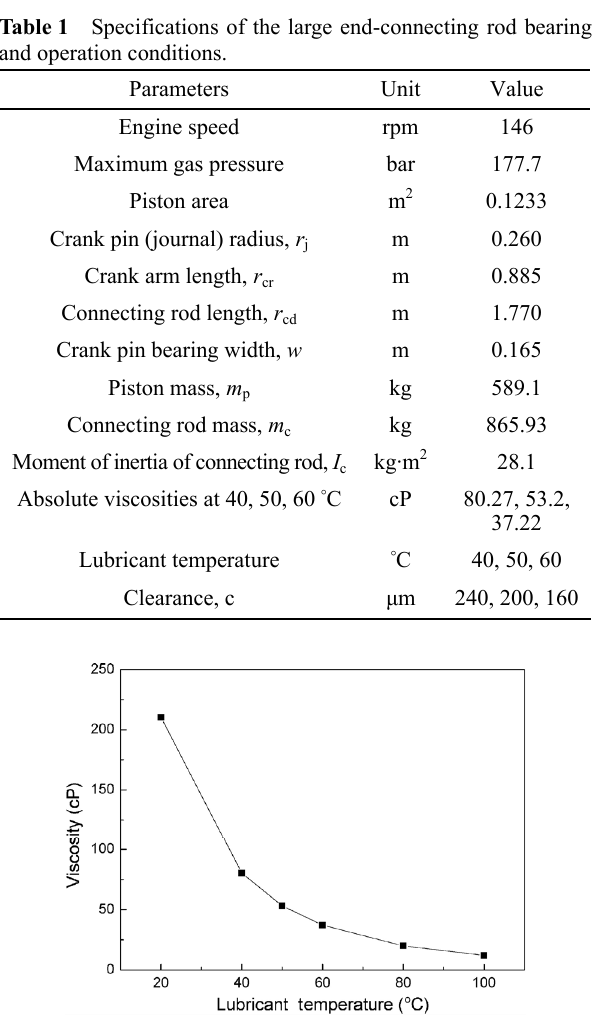
Fig. 4 Measured viscosity of lubricant with a